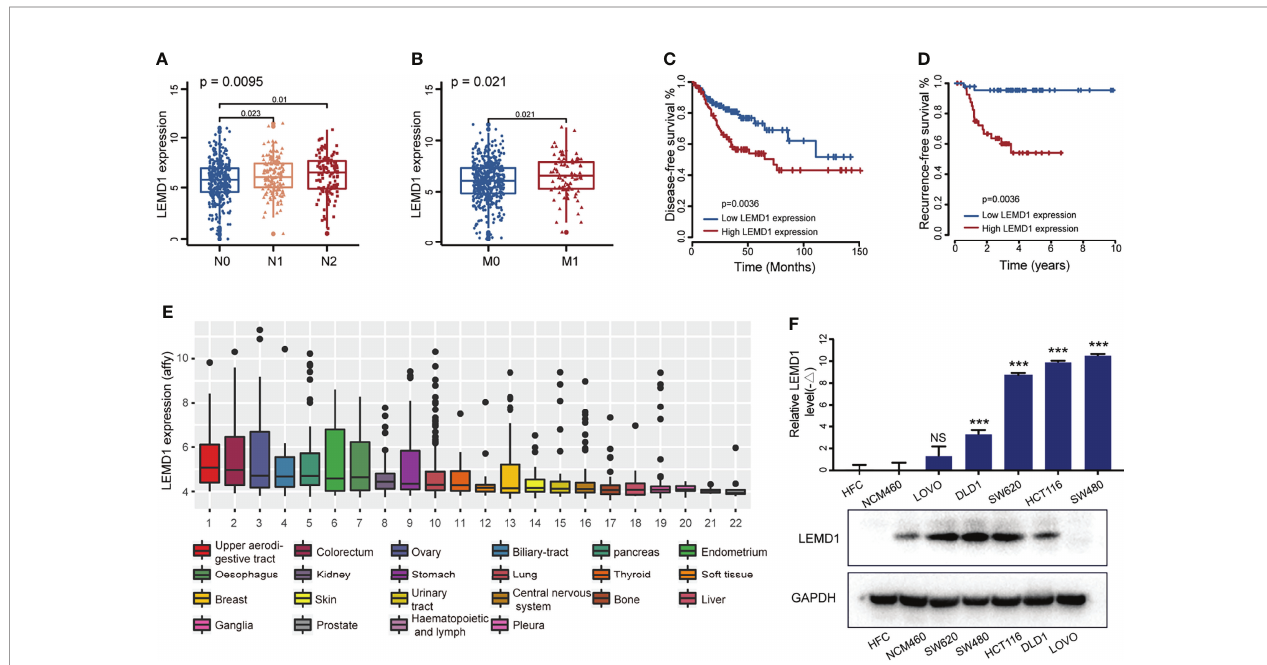
FIGURE 5 | LEMD1 was abnormally expressed in CRC and was related to the prognosis of CRC patients. LEMD1 expression in CRC tissue in the TCGA database according to different N stage (A) and M stage (B – D) patients with low expression of LEMD1 have shorter disease-free survival (C) and lower risk of postoperative recurrence (D, E) LEMD1 expression in 22 cancer cell lines in the CCLE database; (F) LEMD1 mRNA and protein expressions in fi ve CRC cell lines and two intestinal epithelial cells. NS, Not Signi fi cant; ***p <